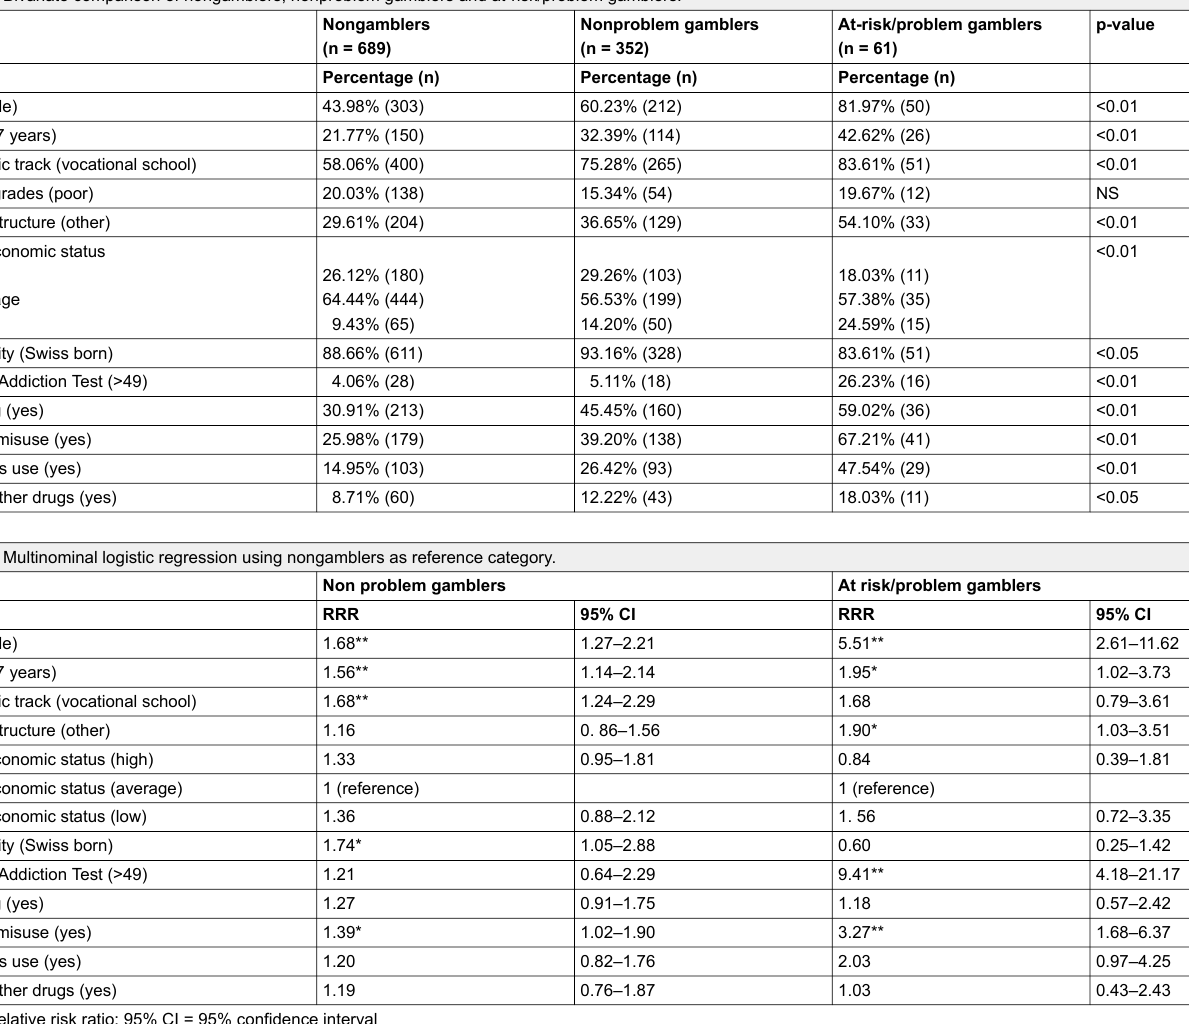
Table 2: Bivariate comparison of nongamblers, nonproblem gamblers and at-risk/problem gamblers.